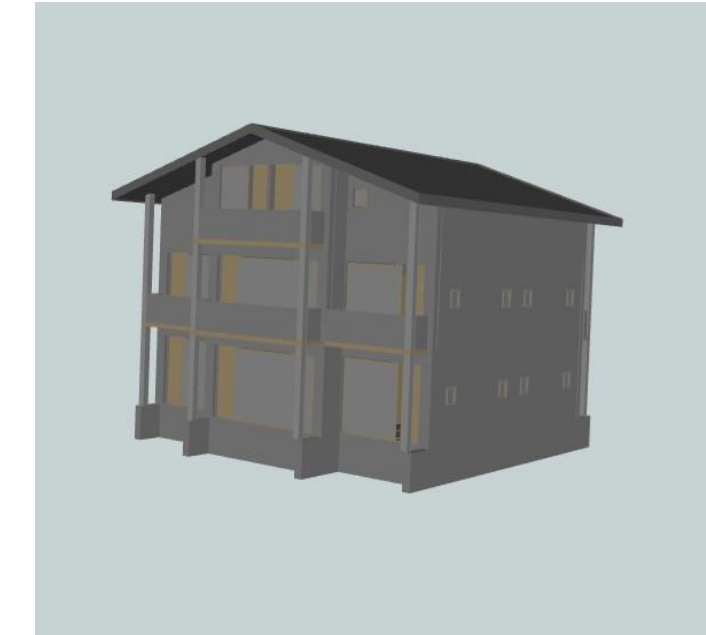
Figure 4.The visualization of BIM